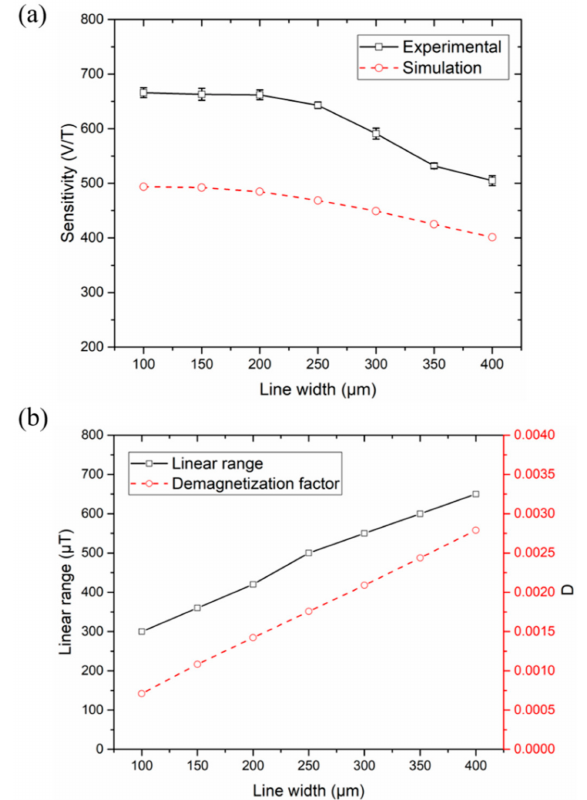
Figure 5. ( a ) The sensitivity of experiment and simulation as a function of the line width of strips. ( b ) The linear range as a function of the line width of strips, and comparison with the demagnetization factor D